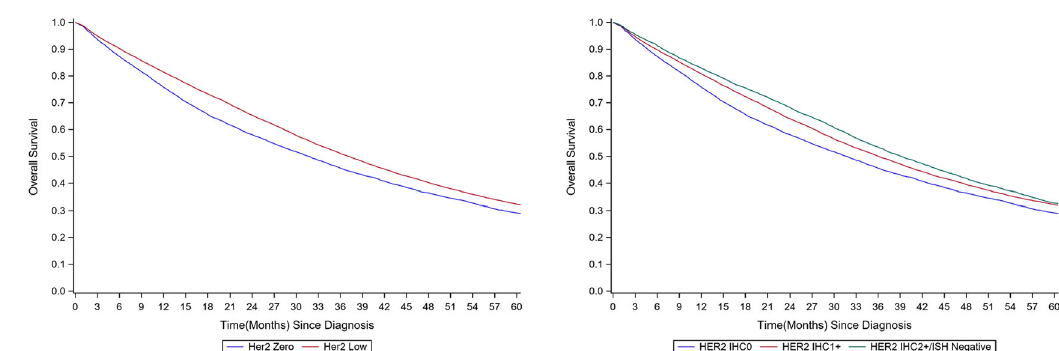
Fig. 2 Survival curve by level of HER2 expression. A (Left): All breast cancer (HER2 Low vs. HER2 Zero). P < 0.001; B (Right): All breast cancer (HER2 IHC2/ISH Neg vs. IHC 1 + vs. IHC 0). P < 0.001; Log-rank test was used to compare the survival across HER2